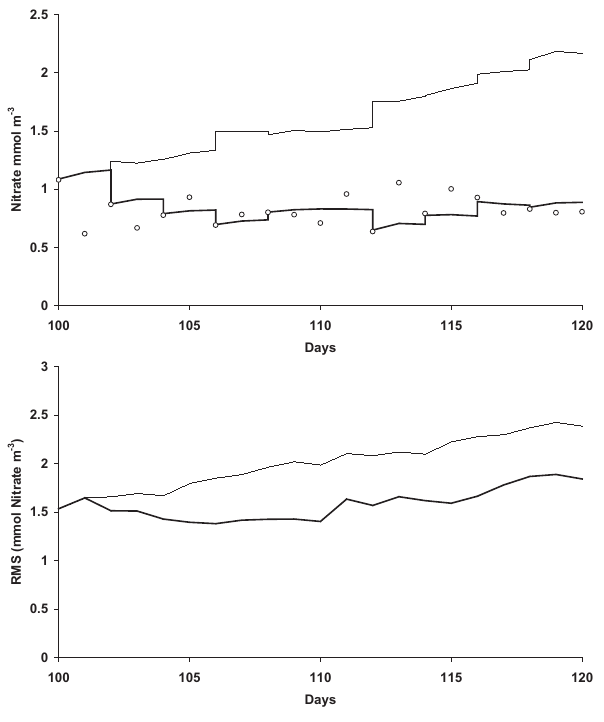
Fig. 9. (a) Effect of assimilation of chlorophyll ( ) and nitrate ( ) compared with data ( ◦ ), on the nitrate simulation at 45m, (b) effect of assimilation of chlorophyll ( ) and nitrate ( ) on the RMS. Fig. 10. (a) Effect of assimilation of chlorophyll ( ) and ni-